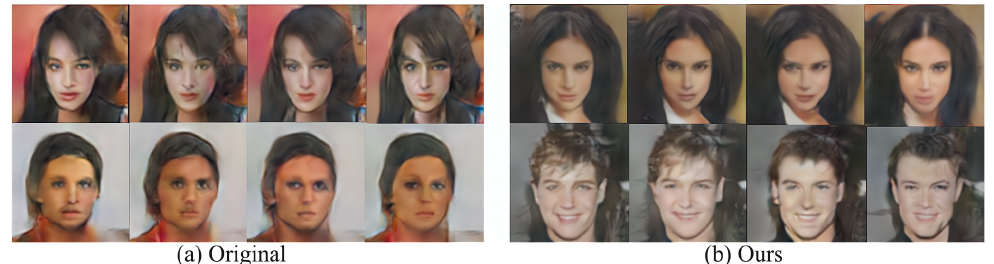
Figure 4. Graph generated without our Network(DCGAN [33]) ( a ), with ours ( b